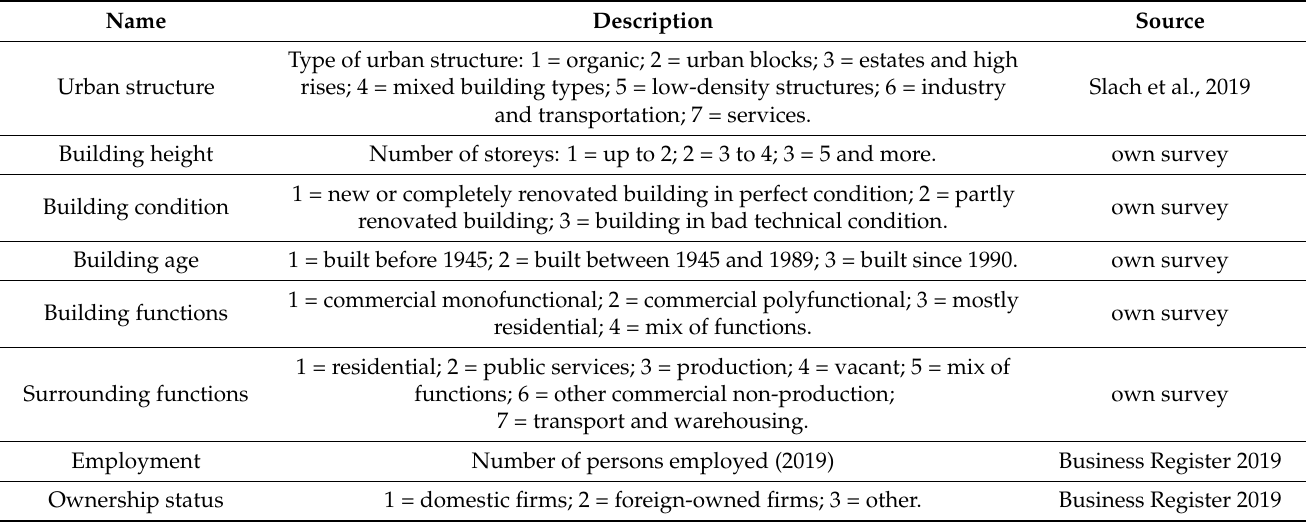
Table 1. Variables used in statistical